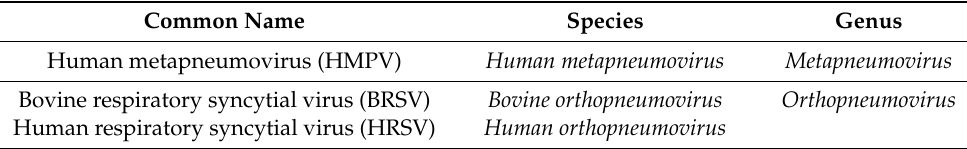
Table 2. Nomenclature of several viruses from Family Pneumoviridae .